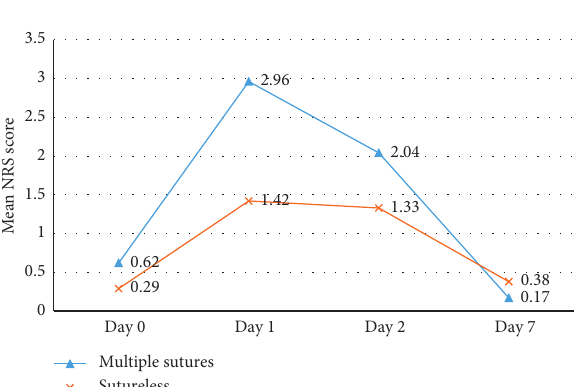
Figure 1: Comparison of pain between group 1 (multiple sutures) and group 2 (sutureless) on patients undergoing third molar surgery using NRS score.